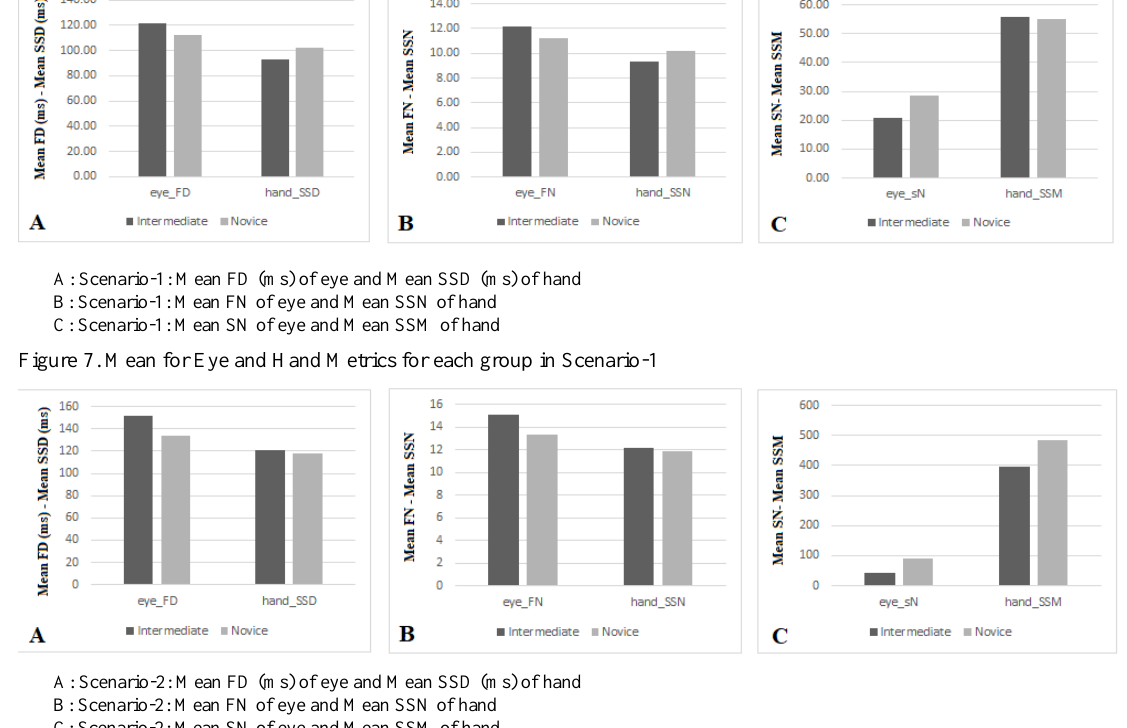
Figure 8. Mean for Eye and Hand Metrics for each group in